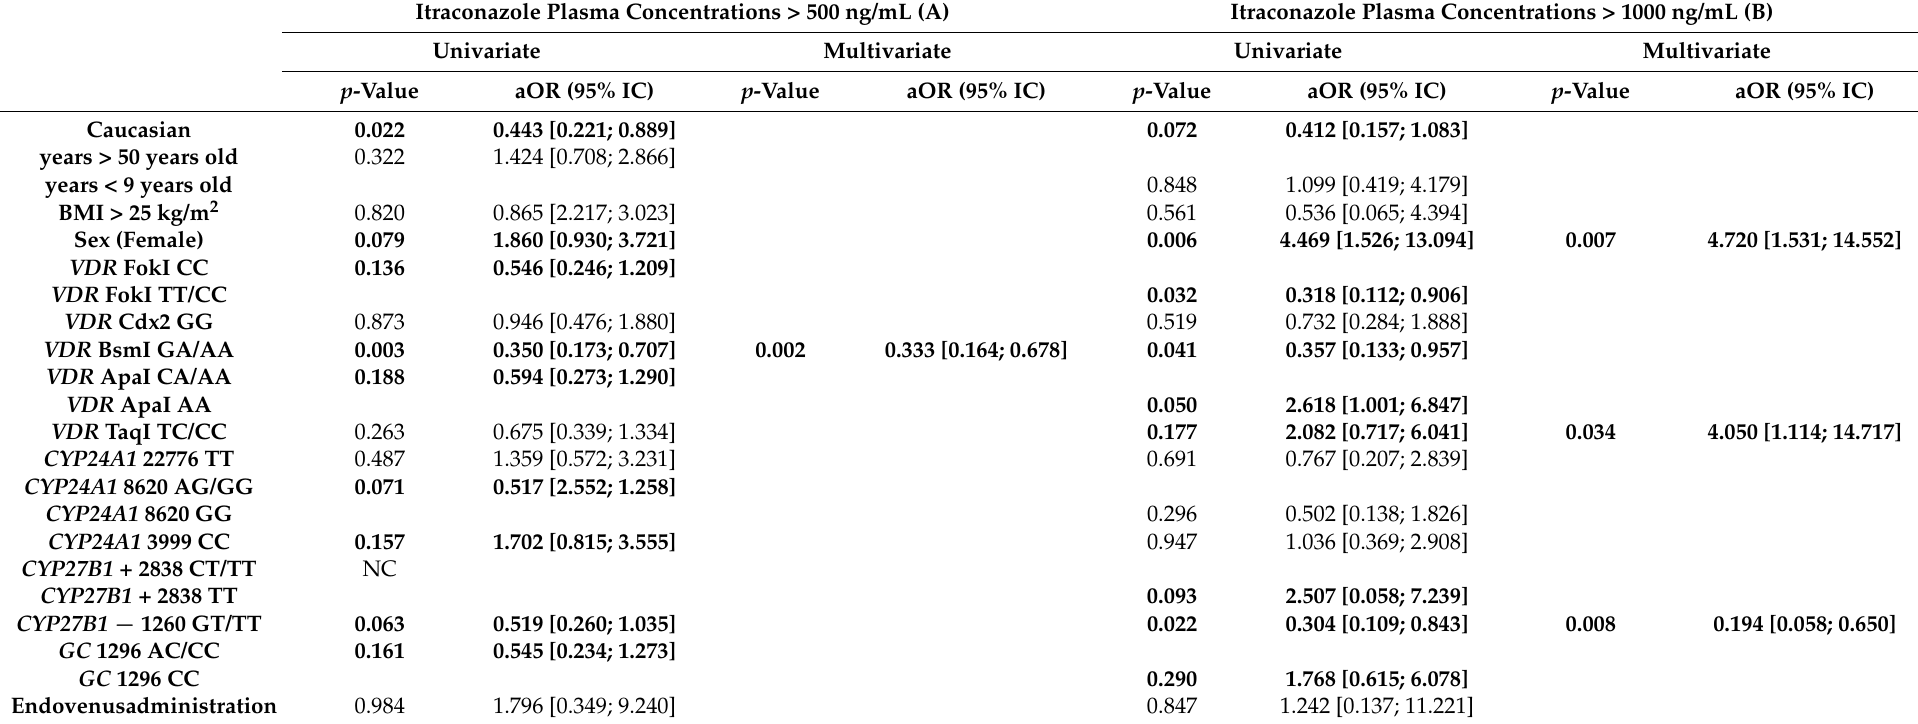
Table 4. Logistic regression analysis: factors able to predict itraconazole plasma concentrations over efficacy cut-off limits (>500 ng/mL) ( A ) and toxicity cut-off limits (>1000 ng/mL) ( B ). Bold characters represent statistically significant values. NC: not statistically comparable since one group is